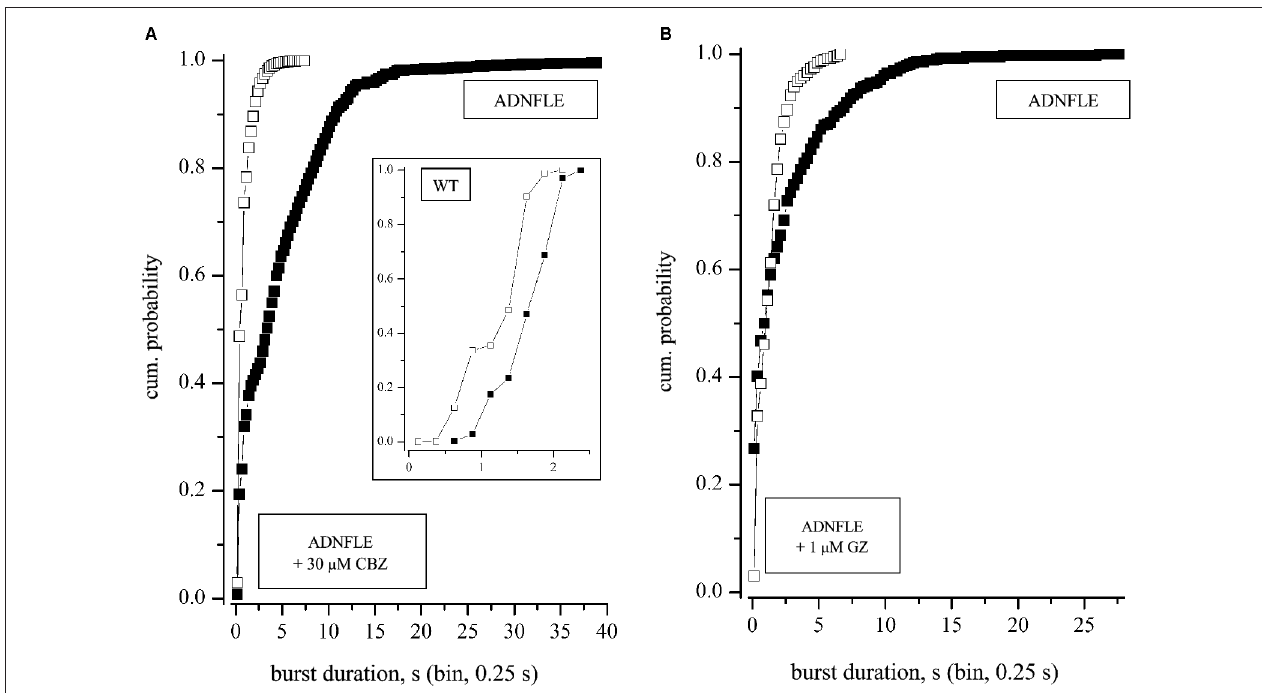
Superimposed cumulative histograms of the BD in the absence (2 h; control) and in the presence of 1 µ M GZ (2 h). The networks recovered the initial level of activity, after washout (not shown). For both CBZ and GZ, data are representative of 3 experiments carried out on mice from different litters. In both A and B the application of the non-parametric Kruskal-Wallis tests resulted in p -values <